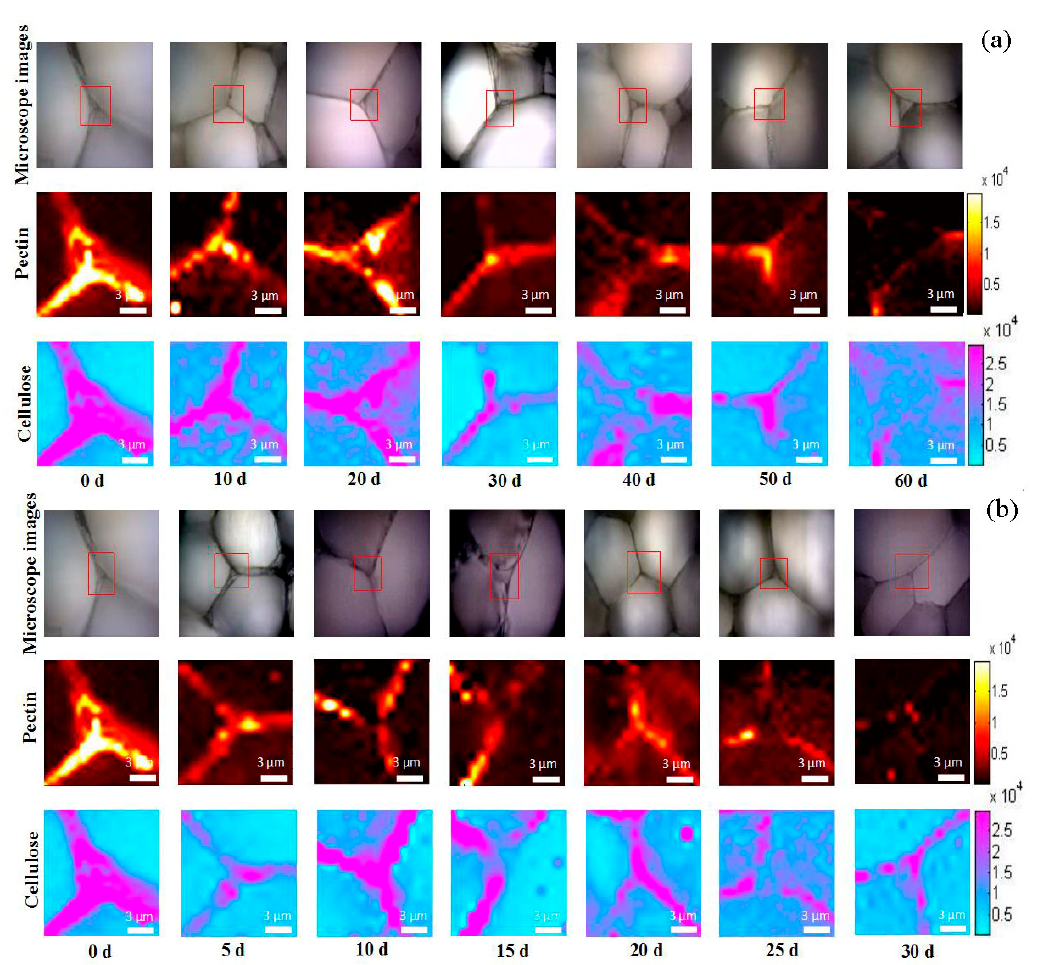
Figure 2. CRM hyperspectral images of cell wall in peach during the postharvest at 0 ◦ C ( a ) and 20 ◦ C ( b ). The Raman images were obtained by integrating Raman bands from 1040 to 1200 cm − 1 for cellulose, and from 840 to 880 cm − 1 for pectin. The red squares on the microscope images mark the measurement areas. The red squares on the microscope images mark the measurement areas. Since 0 d is the starting point of the postharvest storage, images at 0 ◦ C and 20 ◦ C on 0 d were the same as they were obtained from the same samples.